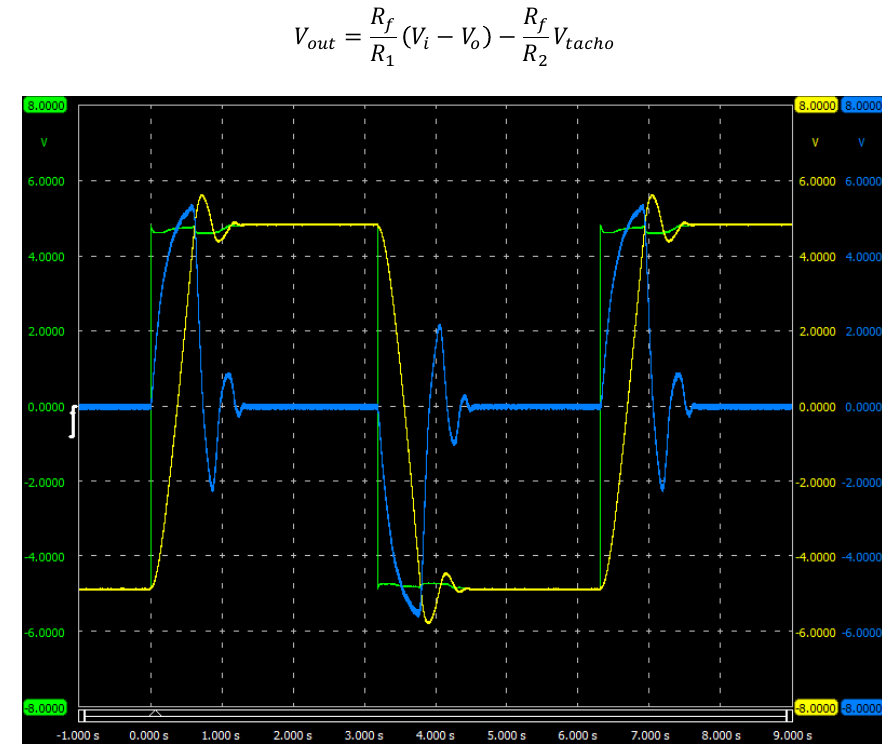
Fig. 5. Tachometer signal (in